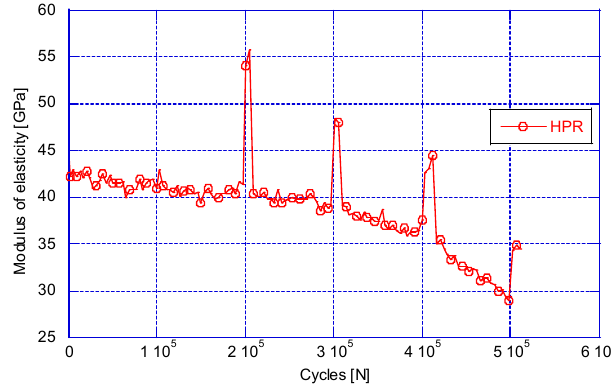
Figure 11. Modulus of elasticity evolution during a Locati test.